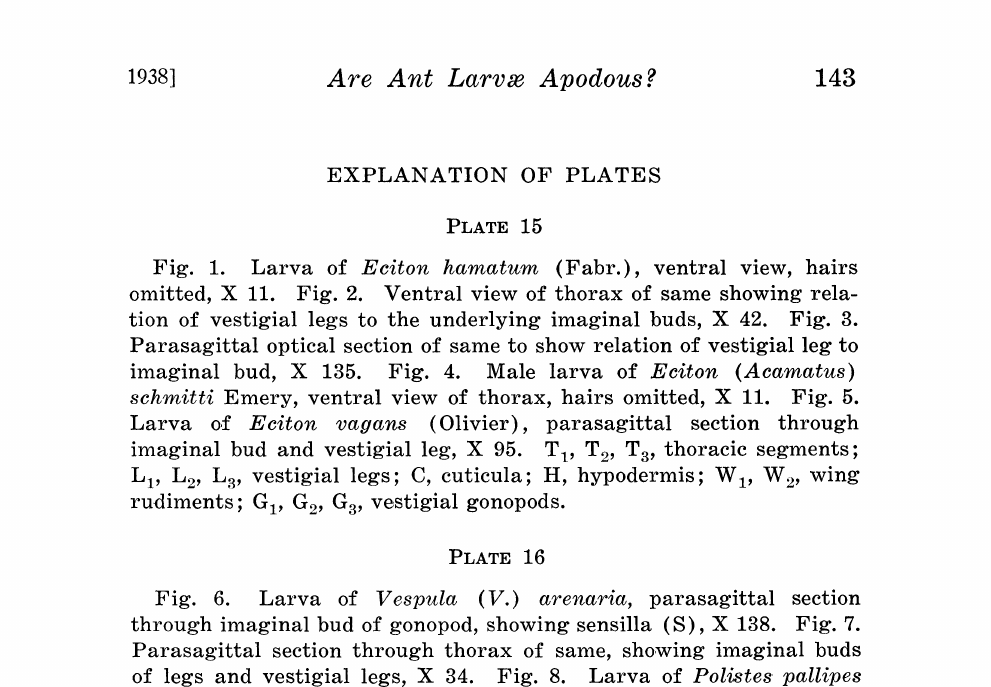
Larva of Vespula (V.) arenaria, parasagittal section through imaginal bud of gonopod, showing sensilla (S), X 138. Fig. 7. Parasagittal section through thorax of same, sho.wing imaginal buds of legs and vestigial legs, X 34. Fig. 8. Larva of Polistes pallipes LePeletier, ventral view, X 6. Fig. 9. Enlargement of mesothoracic portion of Fig. 7, showing nerve (?) to vestigial leg, X 138. Fig. 10. Larva of Pseudomyrma gracilis (Fabr.), ventral view of posterio.r end, X 34; A7, As, A., seventh, eighth, and ninth abdominal segments. Fig. 11. Larva of Dilobocondyla sp., ventral view of anterior end, X